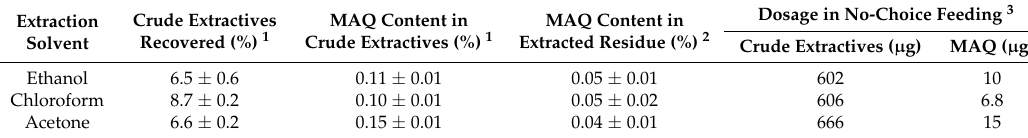
Table 1. Content of 2-methylanthraquinone (MAQ) in crude extractives and residues of T. grandis heartwood and the dosages of crude extractives and MAQ used in no-choice feeding tests. Dosage in No-Choice Feeding 3 MAQ Content in MAQ Content in Crude Extractives Extraction Crude Extractives (%) 1 Extracted Residue (%) 2 Recovered (%) 1 Solvent Crude Extractives ( µ g) Ethanol